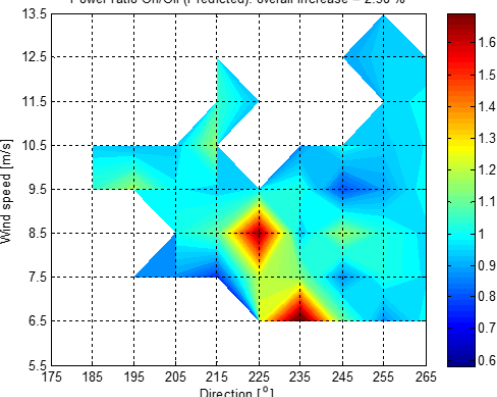
Figure 20. Ratio of model predictions of power in each bin (com- pare Fig.